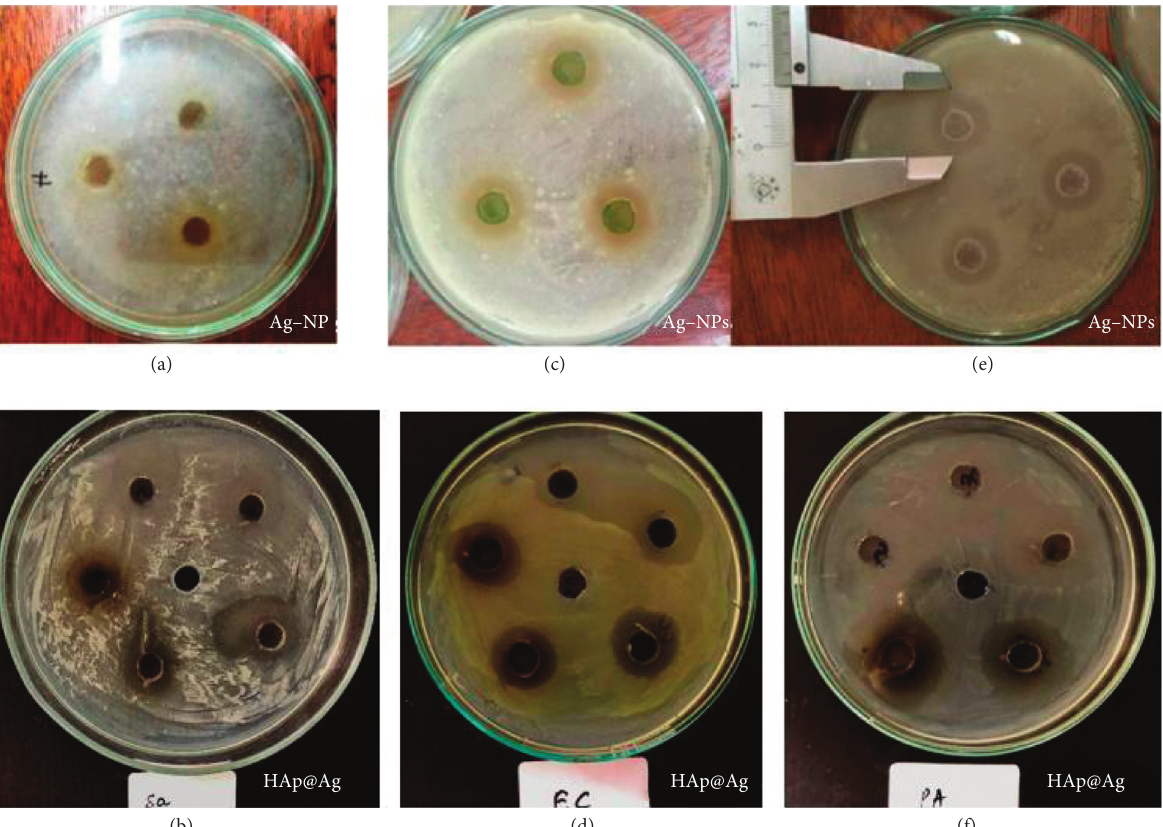
Figure 13: Inhibition zone photographs of the Ag-NPs and HAp@Ag nanocomposites against bacteria S. aureus (a, b), E. coli (c, d), and P. aeruginosa (e, f). The positions (a, c, e) correspond to Ag-NPs concentration of 120 ppm, and the positions (b, d, f) correspond to HAp@ Ag nanocomposite concentration of 1.25mg · mL − 1